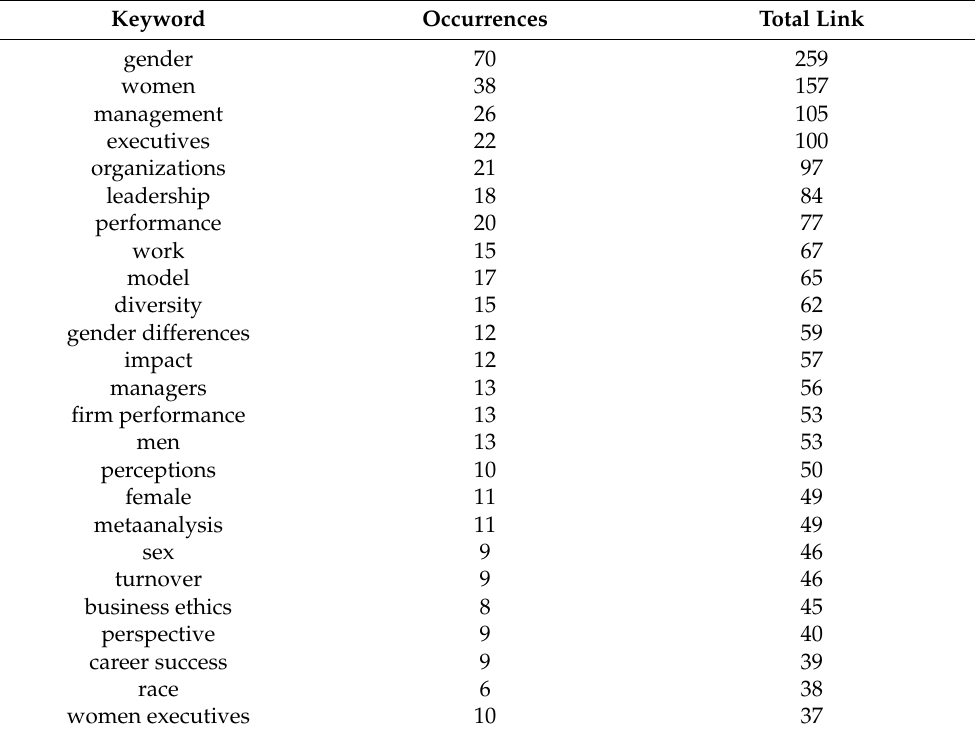
Table 7. Top 25 Keyword by number of